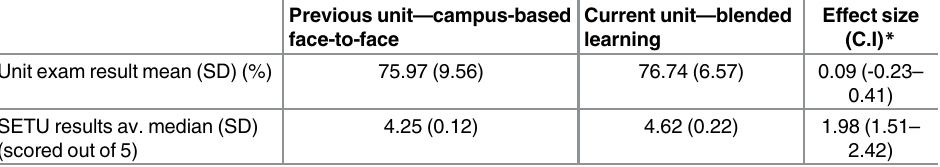
Table 2. Summary of Secondary